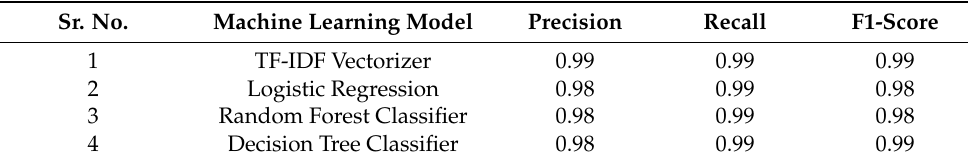
Table 5. Precision, recall, F1-score after applying machine learning